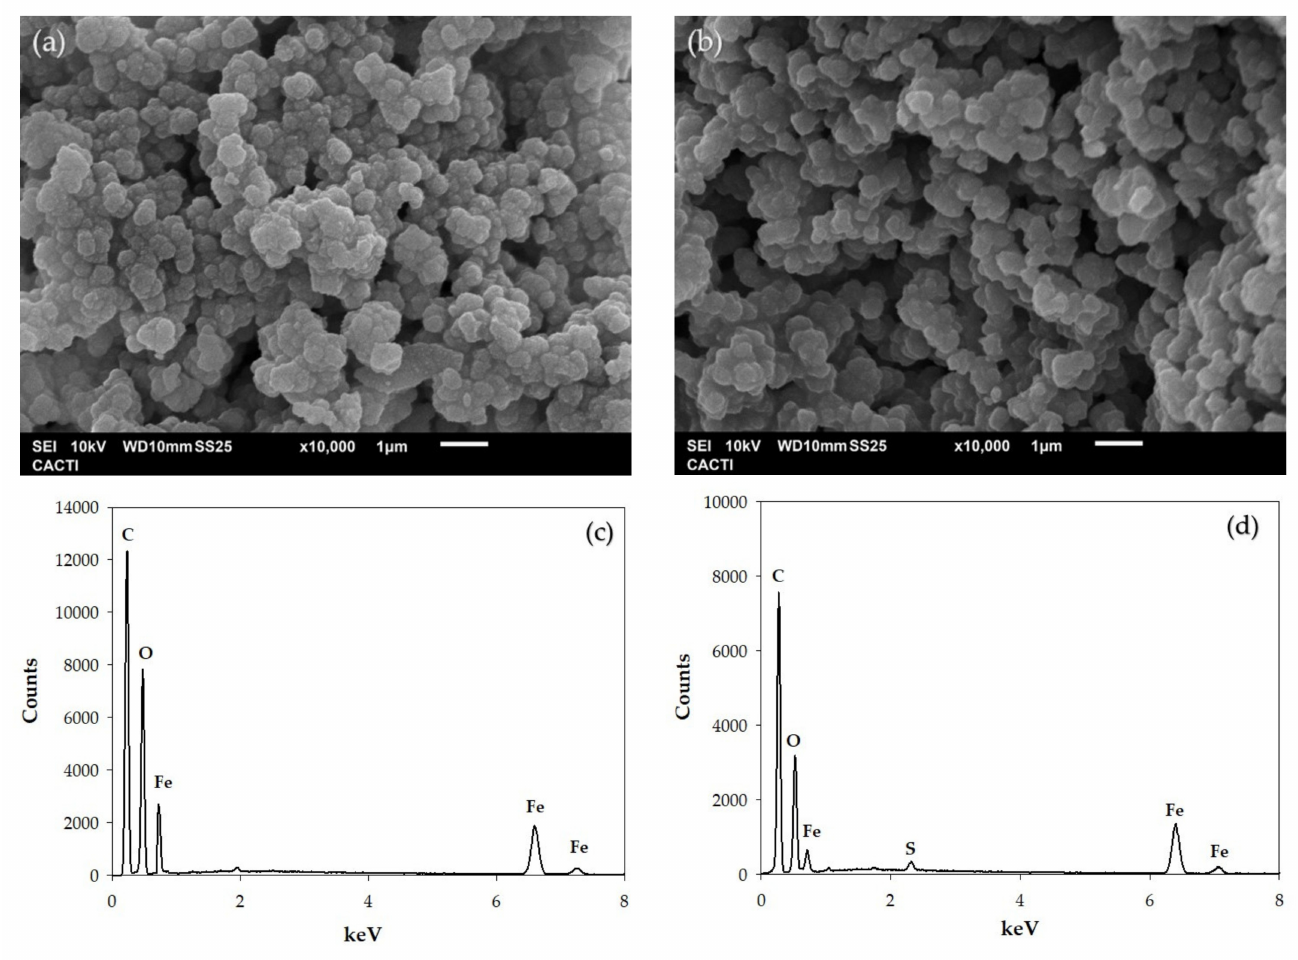
Figure 7. SEM-EDS images and mapping of Basolite ® F-300: ( a , c ) initial and ( b , d ) after four